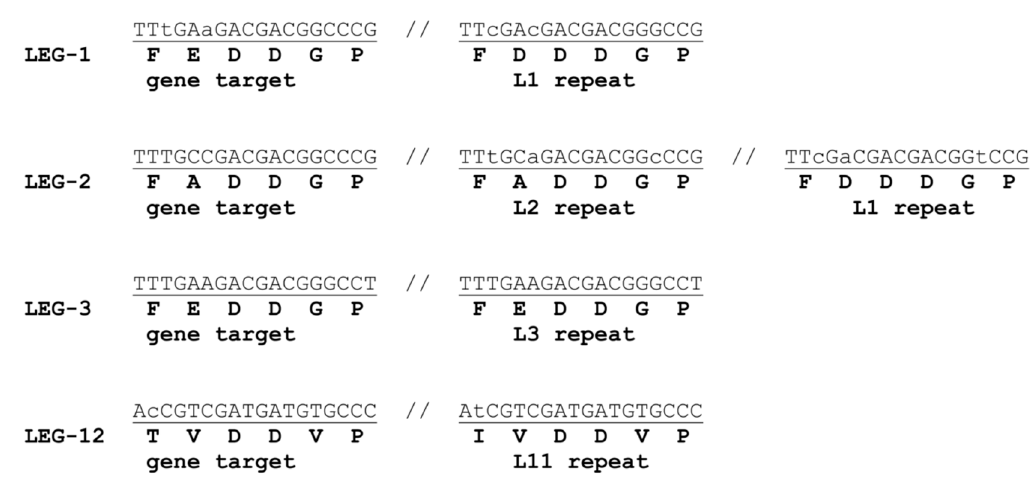
Figure 2. Target site duplications (TSDs) in Legionella ddxp genes. DNA duplications flanking DNA modules encoding L1, L2, L3, and L11 repeats in the Legionella DDxP proteins LEG-1, LEG-2, and LEG-12, respectively, are underlined. The corresponding amino acids residues in each protein are shown. Nucleotide changes between TSDs are denoted by lower case letters.